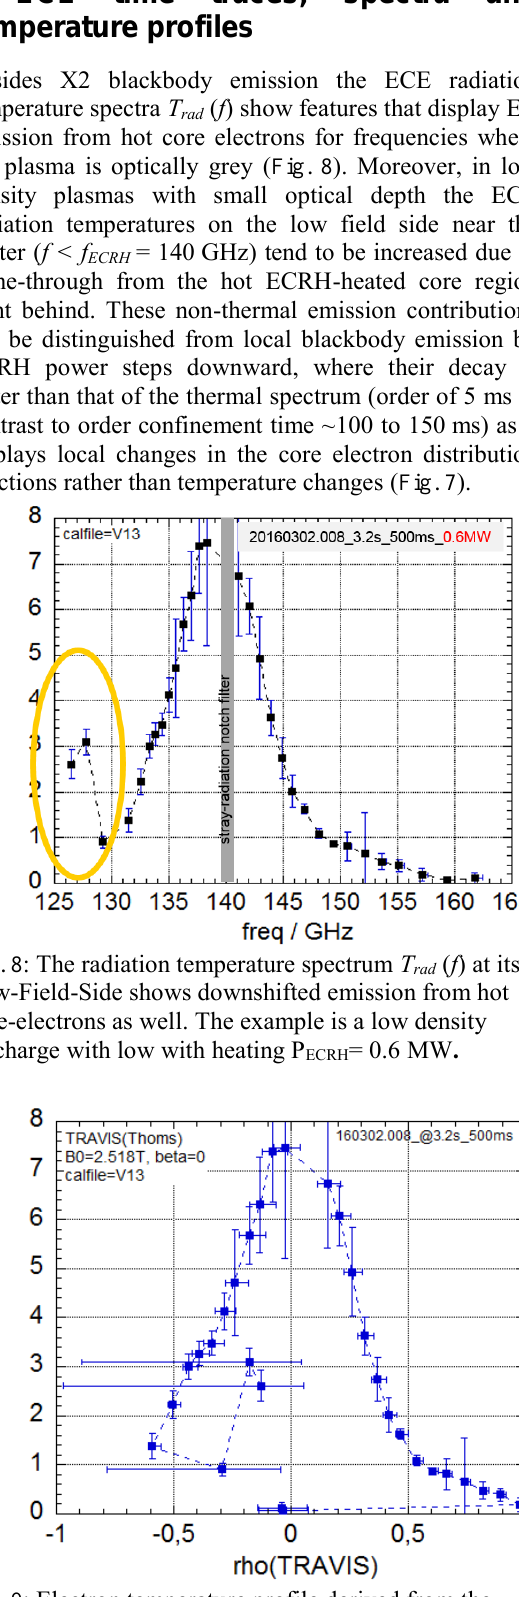
Fig. 9 : Electron temperature profile derived from the spectrum above using the beam tracing and